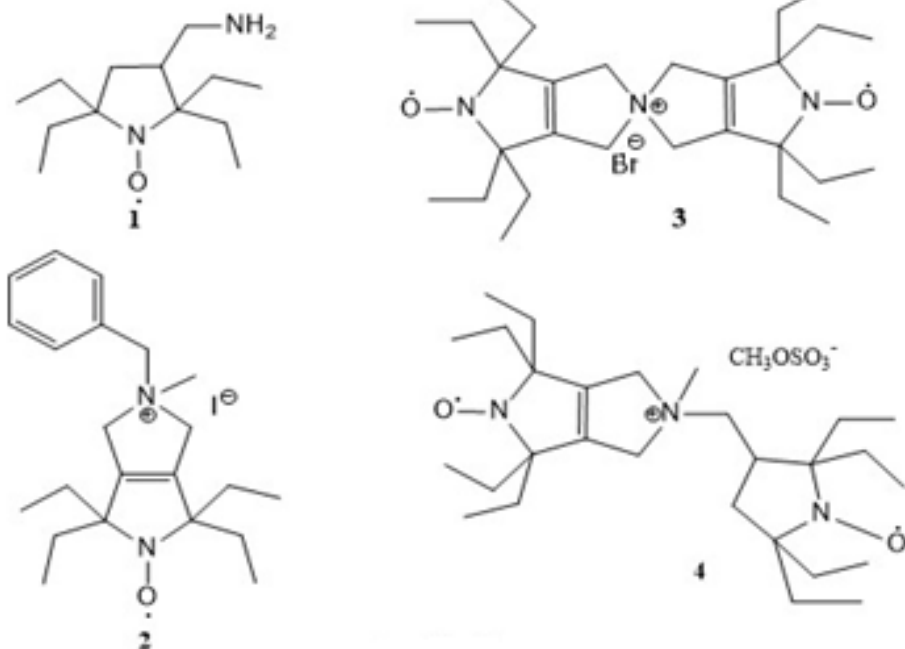
Figure 1. Chemical structures of monoradicals 1 and 2 and binitroxyl radicals 3 and 4.